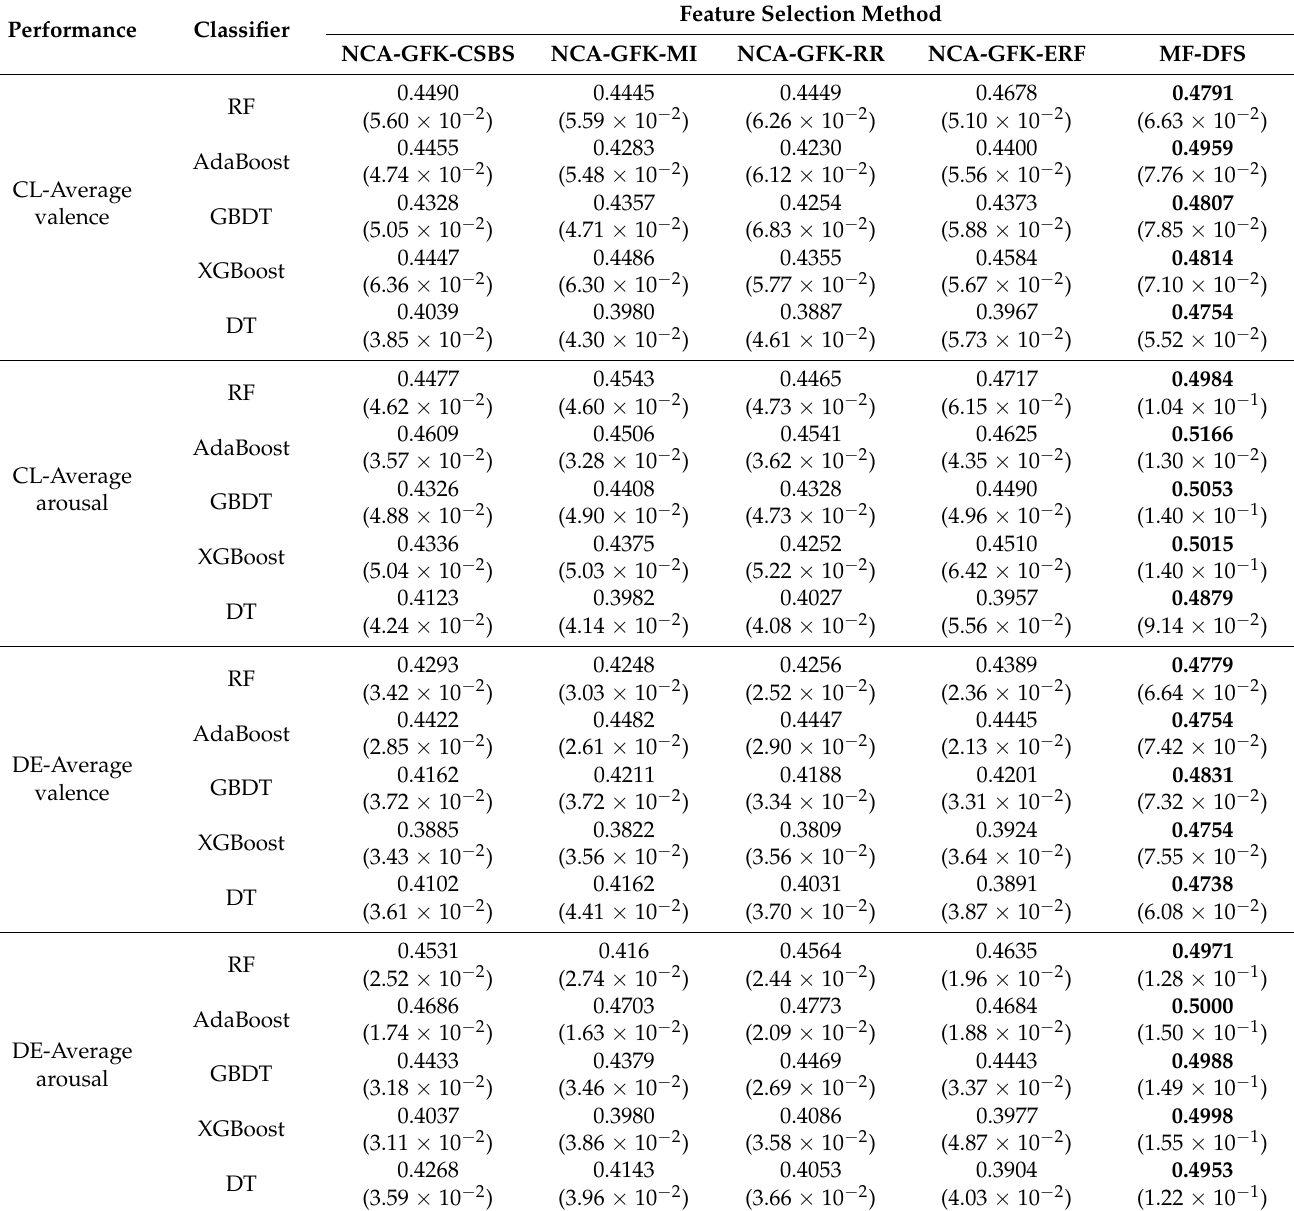
Table 4. Classification performance comparison across different combinations of feature selection methods and machine learning classifiers on the DEAP